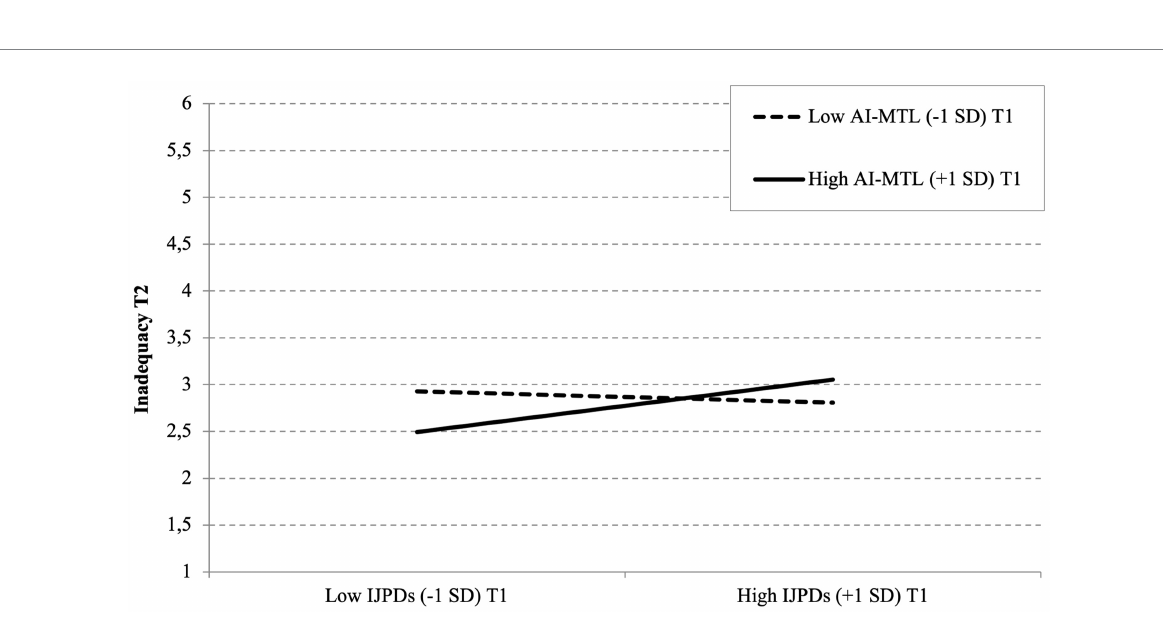
leader than as a follower (Chan and Drasgow, 2001). Equally,